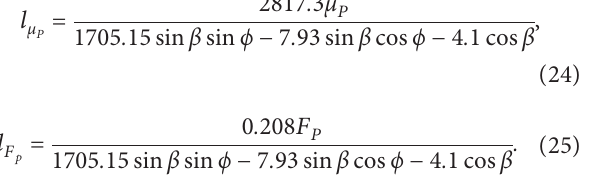
and the friction coefficient between the disc valve μ p under different βμ P and the well inclination angles β βμ P